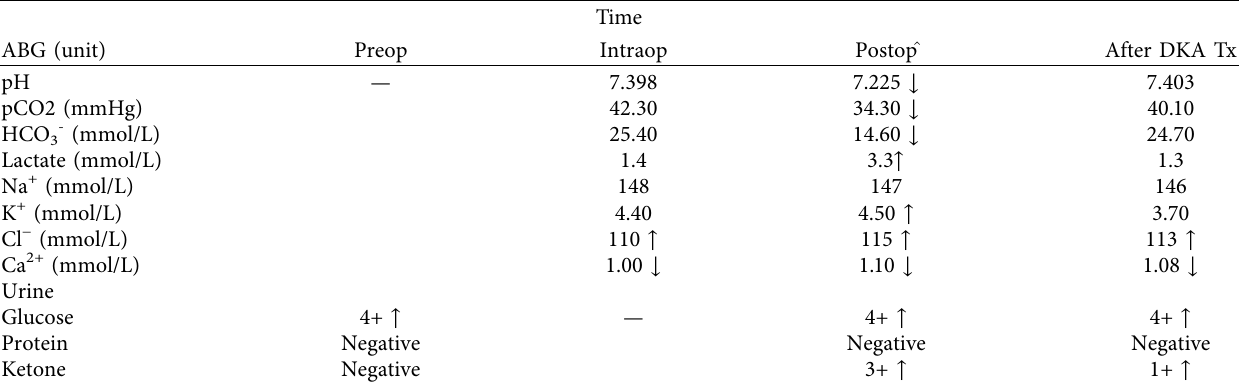
Table 2: ABG and urinalysis of our patient at 4 different